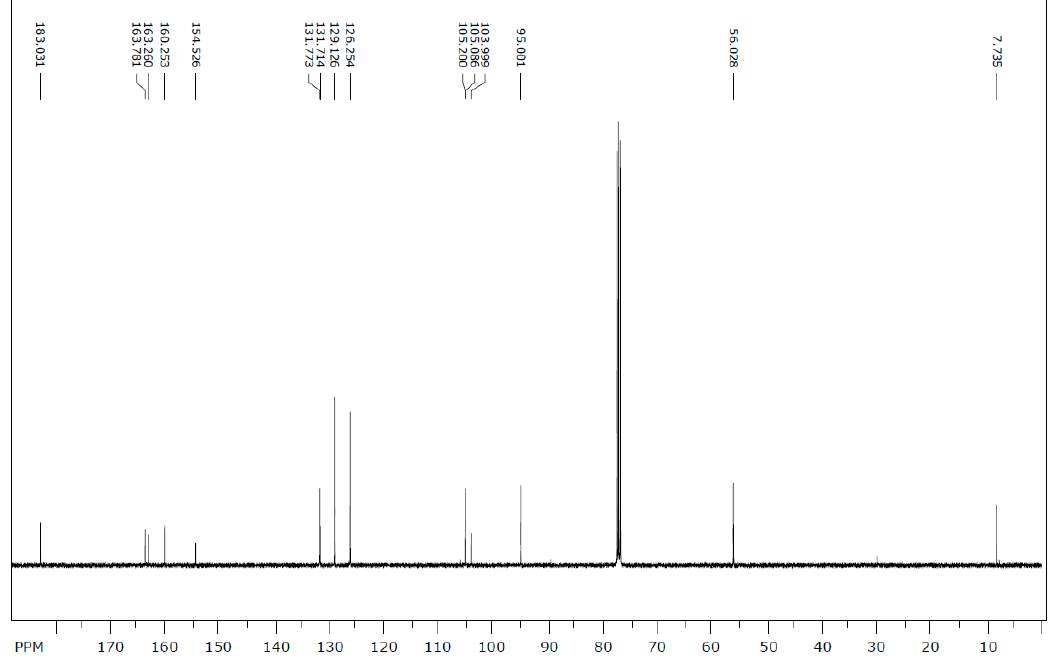
Figure 3. 13 C-NMR spectrum of 6-methyltectochrysin.